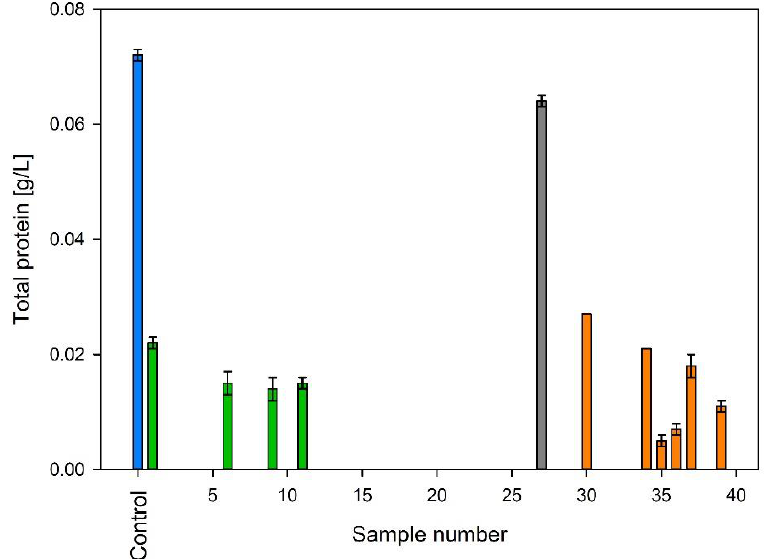
Figure 5. Residual protein concentration after the addition of 1 g/L bentonite to a model system. Green bars represent wine-fining agents, orange bars are pharma/beauty products, and the grey bar is the desiccant. Missing bars indicate either unavailable products that were not included in the study or bentonites that removed the protein below the detection limit.